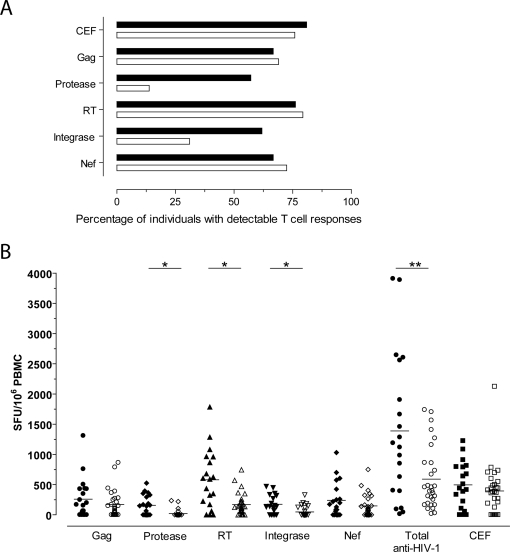
Responses to HIV-1 peptides and the CEF pool.A) Percentage of individuals making responses from either group: solid bars indicate the viremic partner group and open bars represent the non-viremic partner group. There was a significant difference in the number of individuals responding to Protease and Integrase peptide pools (p = 0.04 and p = 0.002 respectively), as determined by Fishers exact test. No difference was seen for any other stimuli. B) Magnitude of IFN-γ T cell responses to the HIV-1 or CEF peptide pools, and the total cumulative anti-HIV-1 response. Responses from individuals within the viremic partner group (closed symbols) and individuals within the non-viremic partner group (open symbols) showed significant differences for Protease, RT, Integrase and the total cumulative anti-HIV-1 response, *p<0.001 and **p = 0.0274 respectively. The median of each group is plotted as a horizontal line.